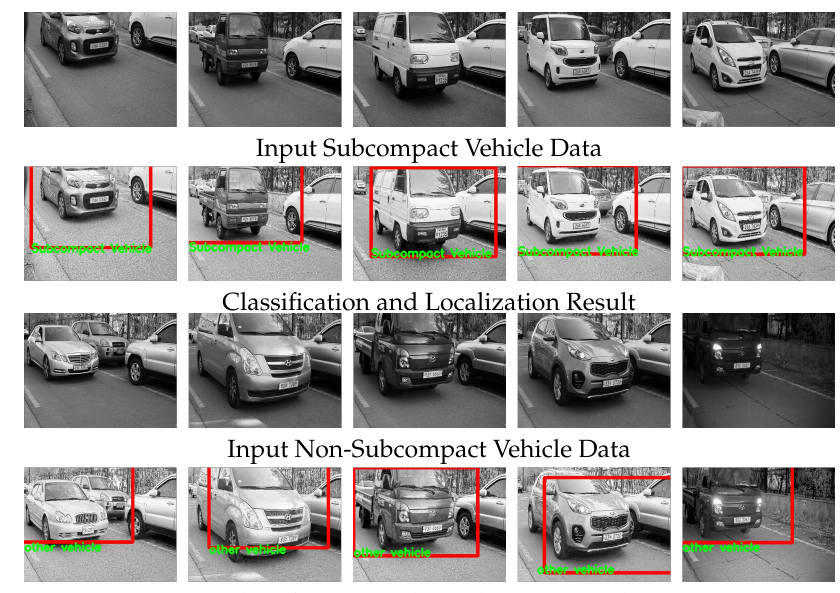
Figure 14. Classification and localization